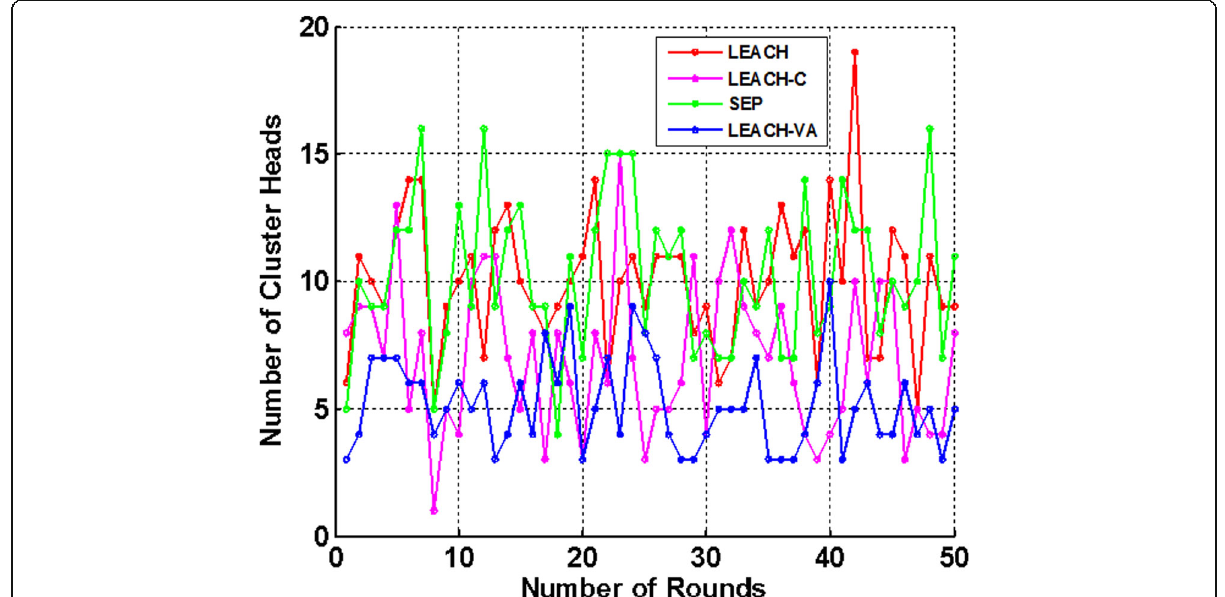
Fig. 5 Number of rounds versus the number of cluster